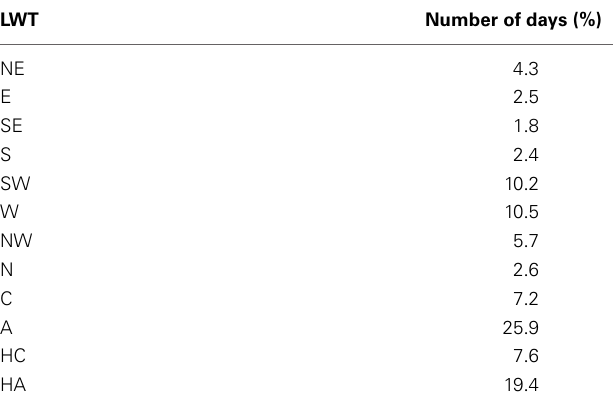
Table 1 | Frequency (%) of occurrence of Lamb circulation weather types during the 1/12/1999 to 30/11/2004